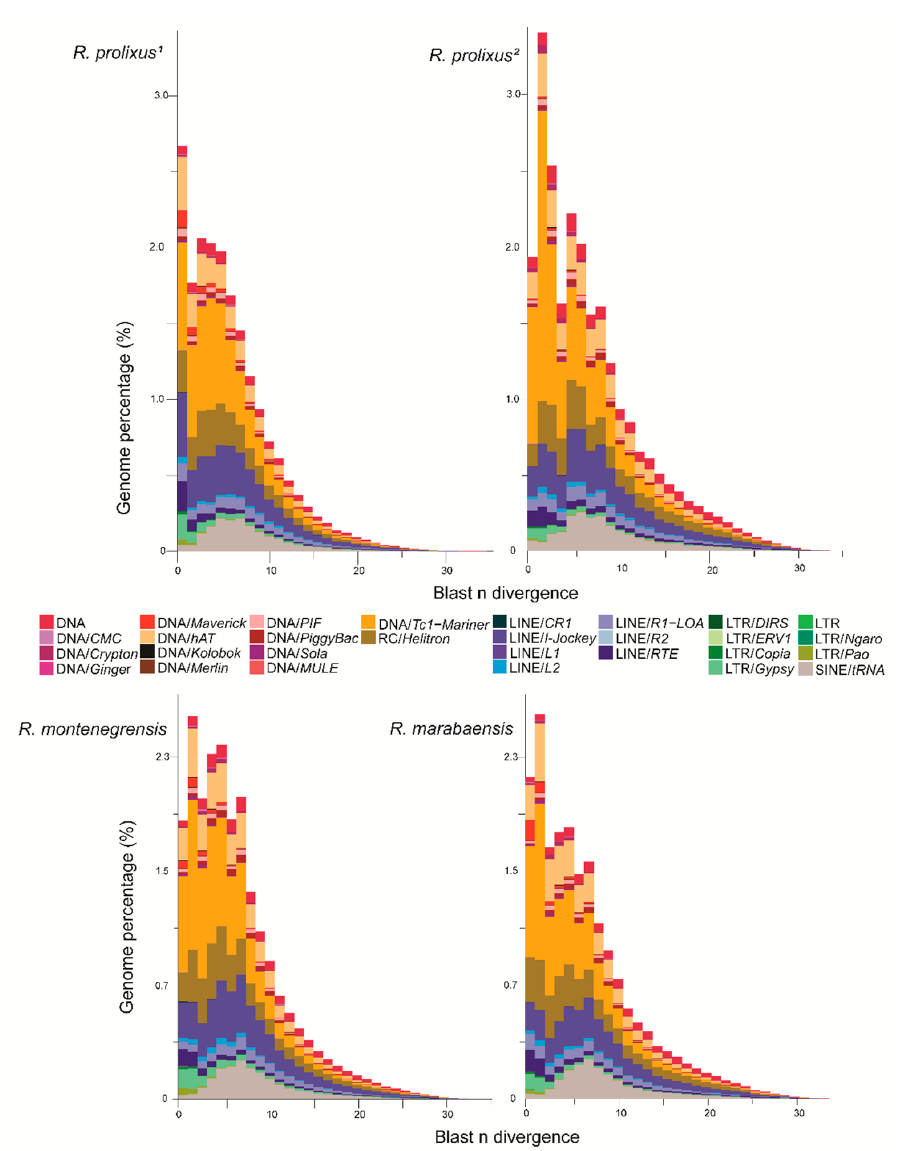
Figure 3. Distribution of TE ages between the Rhodnius genomes. For each species, the nucleotide divergence from BLASTN is calculated between a repeat read and the contig, where it matches the dnaPipeTE assembly. R. prolixus 1 : annotation from raw genomic reads; R. prolixus 2 (annotation from fragmented reads from the assembled genome).